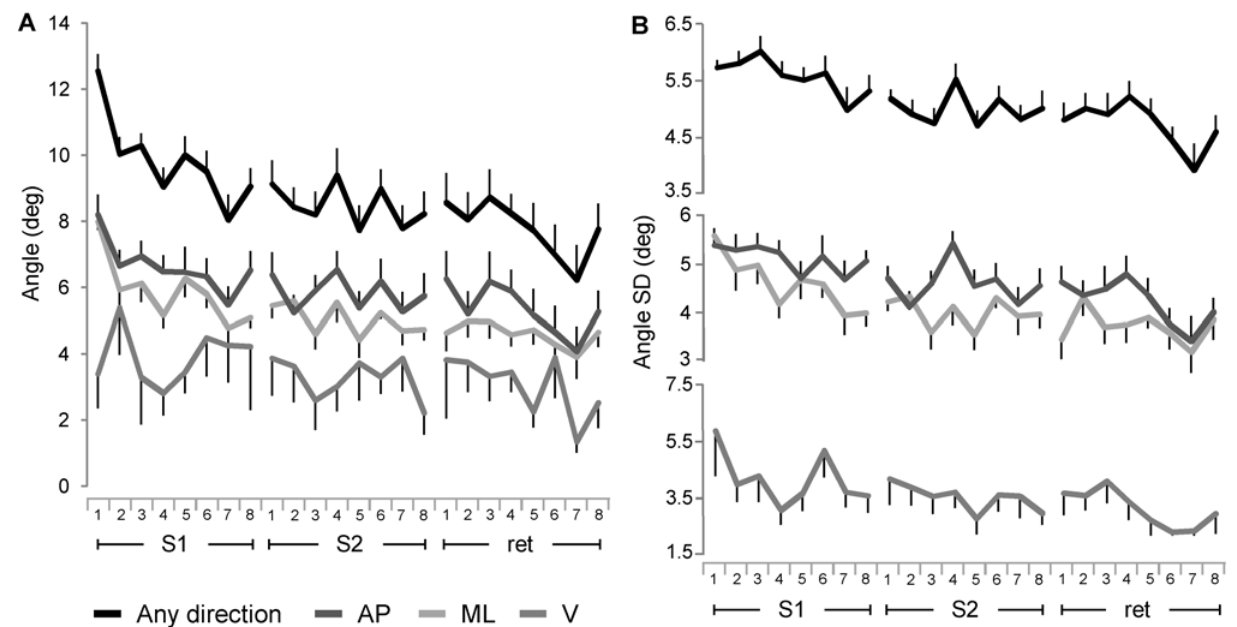
Fig 3. Changes in angular oscillation of the board across the time course of learning. Amplitude (A) and variability (B) of angular oscillation of the board around the horizontal plane for any direction (first plot from the top), for AP and ML directions (second and third plot from the top) and around the vertical axis (most bottom plot). The error bars represent the standard errors. Abbreviations as in Fig 2.